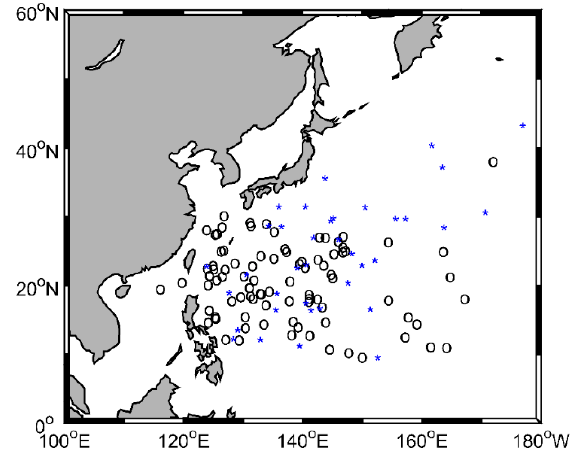
Figure 1. Geographical locations of 125 TC cases in the Northwest Pacific Ocean observed by SMAP. Blue stars and black circles denote that the corresponding asymmetry parameter ( ε ) is larger or smaller than 0.2, for a particular TC, respectively.